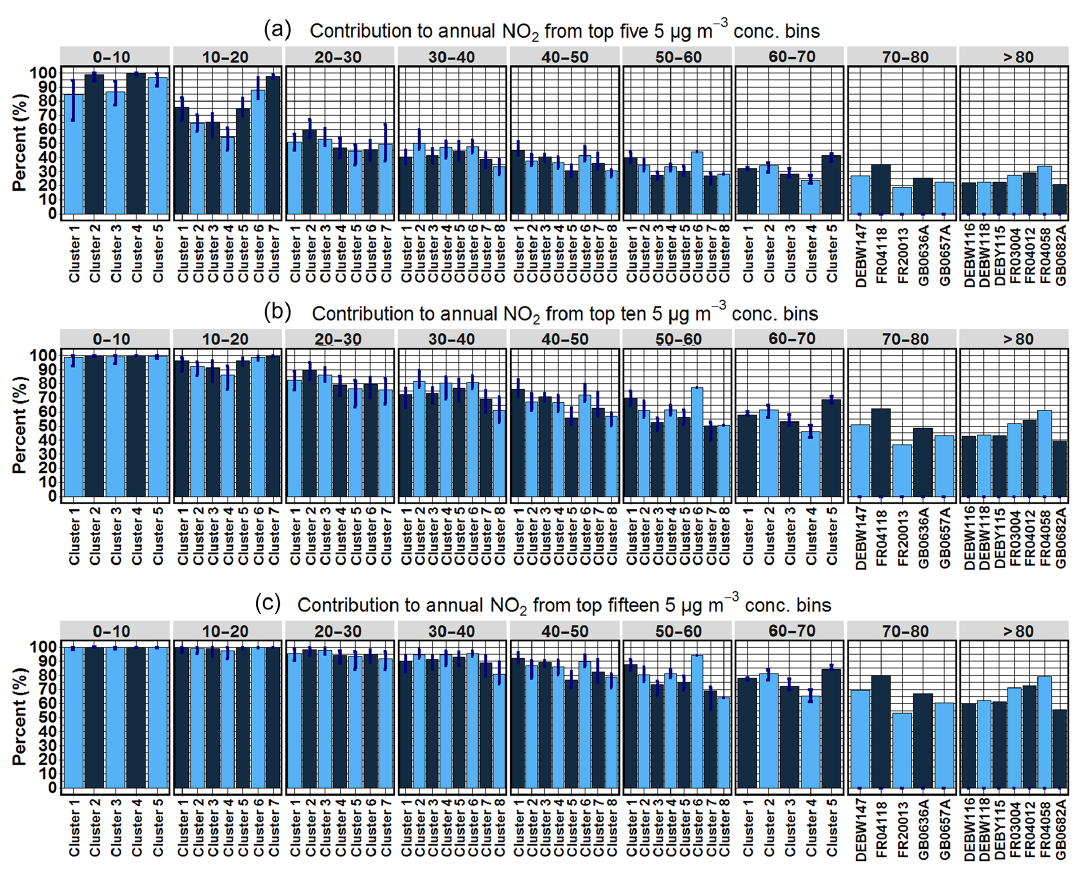
Figure 6. The contribution to 2010–2014 average annual NO 2 concentrations (NO 2AA ) from the (a) five, (b) ten, and (c) fifteen 5µgm − 3 hourly NO 2 concentration bins with the largest contribution to 2010–2014 NO 2AA , for sites with 2010–2014 NO 2AA in 10µgm − 3 bins, and separated by clusters demarcating distinct variation in monthly, hour of day, and hourly NO 2 concentration bin contributions to NO 2AA . These values are a proxy to compare the range of hourly NO 2 concentrations contributing to NO 2AA , and the near 100% contribution for the lower 2010–2014 NO 2AA bins results from the fact that for NO 2AA of 0–10µgm − 3 , there are far fewer high hourly NO 2 concentration values.